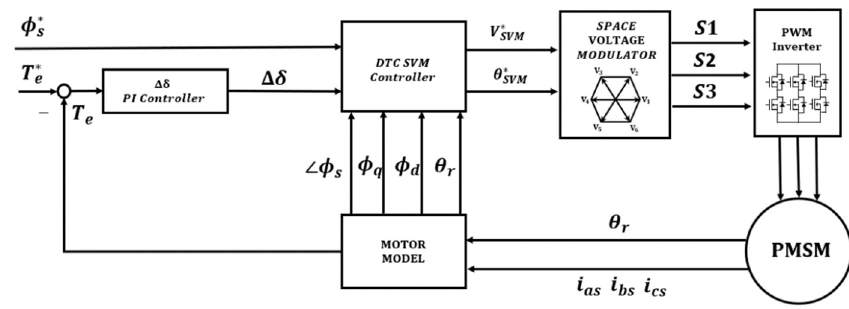
Figure 3. Block diagram of DTC-SVM control .